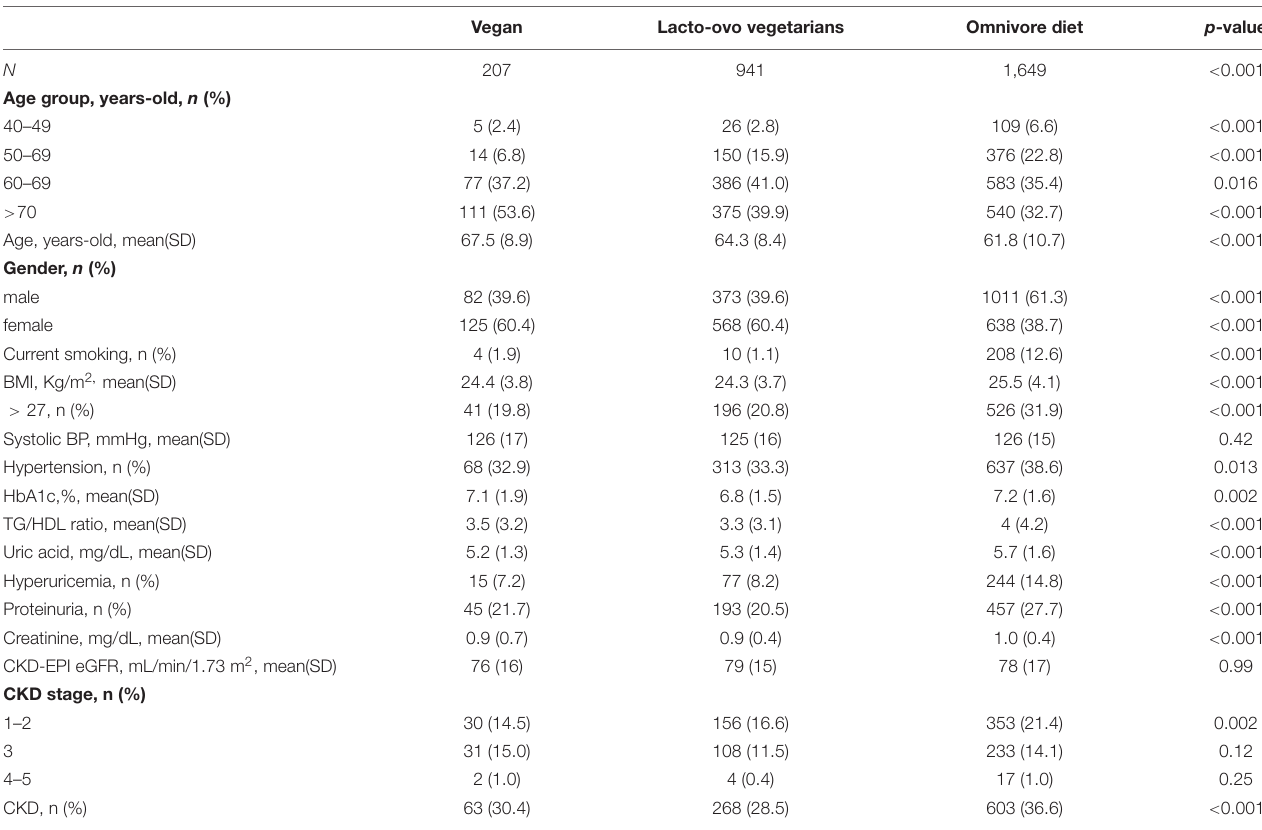
TABLE 1 | The demographic characteristic of subjects in the community.